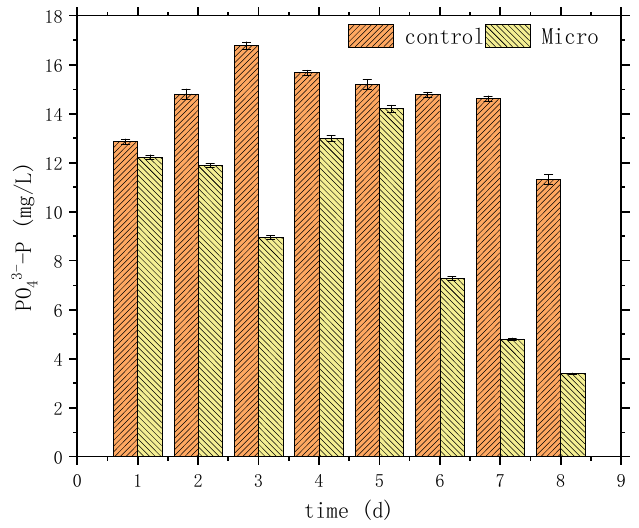
Figure 3. Variation of PO 43 − -P concentration under the microaerobic condition.